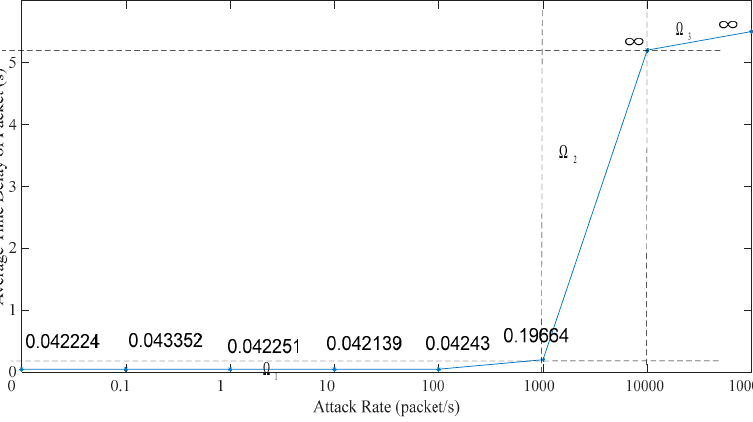
Figure 14. Average transmission time delay under different DoS attack rates.